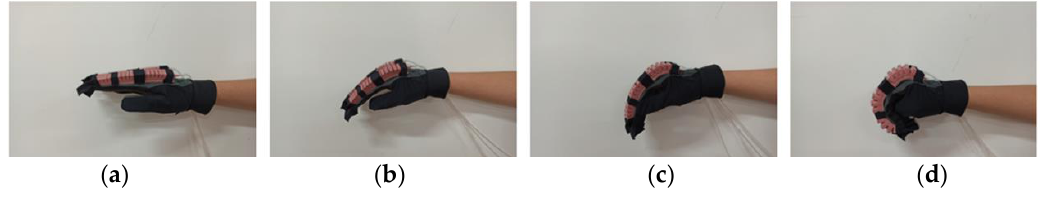
Figure 13. The four wearing states of sExoG. ( a ) Extension, ( b ) Rest, ( c ) Spherical grip, ( d ) Fist.